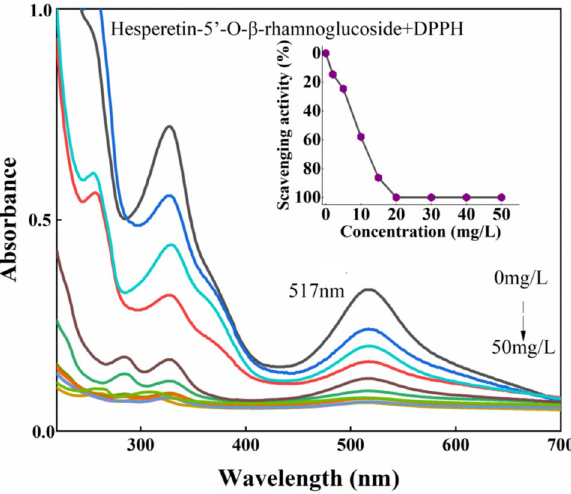
Figure 7. UV–Vis spectra of hesperetin-5 ′ -O-β-rhamnoglucoside-DPPH· complex with oxidant concentration.